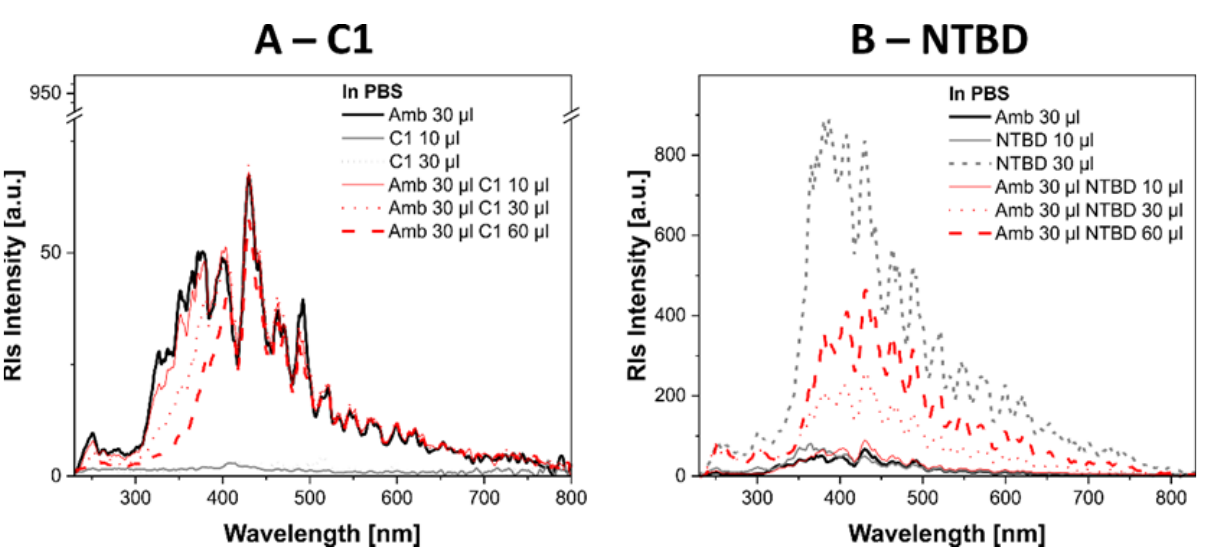
Figure 10. ( A )—resonance light scattering spectra of C1, AmB, and the synergistic C1 + AmB system corresponding to the spectra in Figure 9A,C (analogous concentrations); ( B )—resonance light scattering spectra of NTBD, AmB, and the synergistic NTBD + AmB system corresponding to the spectra in Figure 9B,D (analogous concentrations).